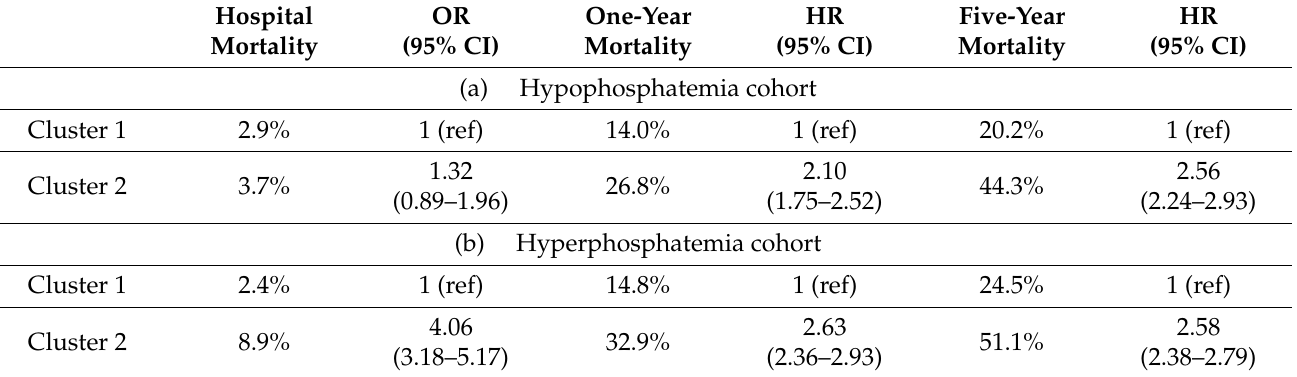
Table 2. Mortality per cluster in hypophosphatemia and